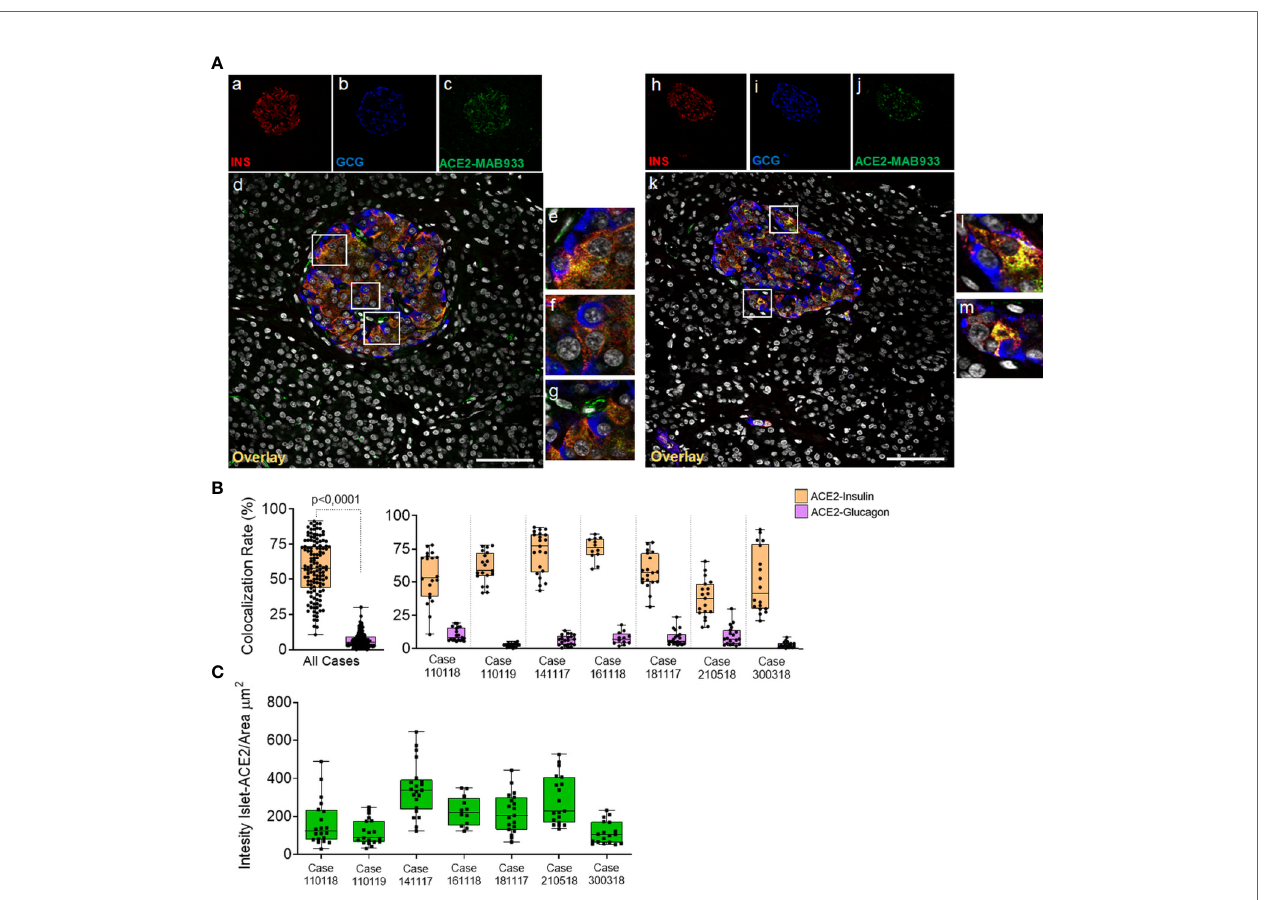
FIGURE 4 | In human pancreaticislets, ACE2 ispreferentially expressed ininsulin-producing b -cells. Triple immuno fl uorescence staining and image analysisofFFPE human pancreaticsection stainedfor insulin (red), glucagon(blue) andACE2 (green). (A) Representative islets of two different cases. Panels-a to -g: representative pancreaticislet of FFPE pancreas block Body01A ofcase #110118. Panels-h to -m: representative pancreaticislet of FFPE pancreas block Body01B of case #141117. Panels-e to -g: digital zoom inimages ofthe pancreaticislet shownin panel-d.Panels-l and -m:digital zoomin images of the pancreatic islet shownin panel-k.Scalebar in panels-dand